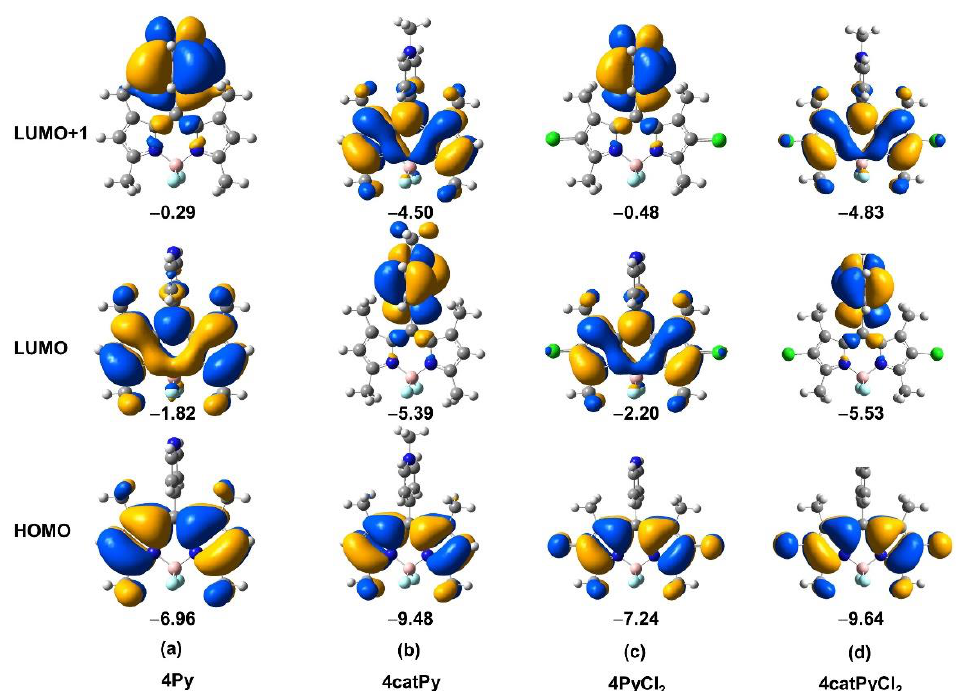
Figure A2. Frontier orbitals of ( a ) 4Py , ( b ) 4catPy , ( c ) 4PyCl 2 and ( d ) 4catPyCl 2 BODIPYs. Orbital energies in eV.